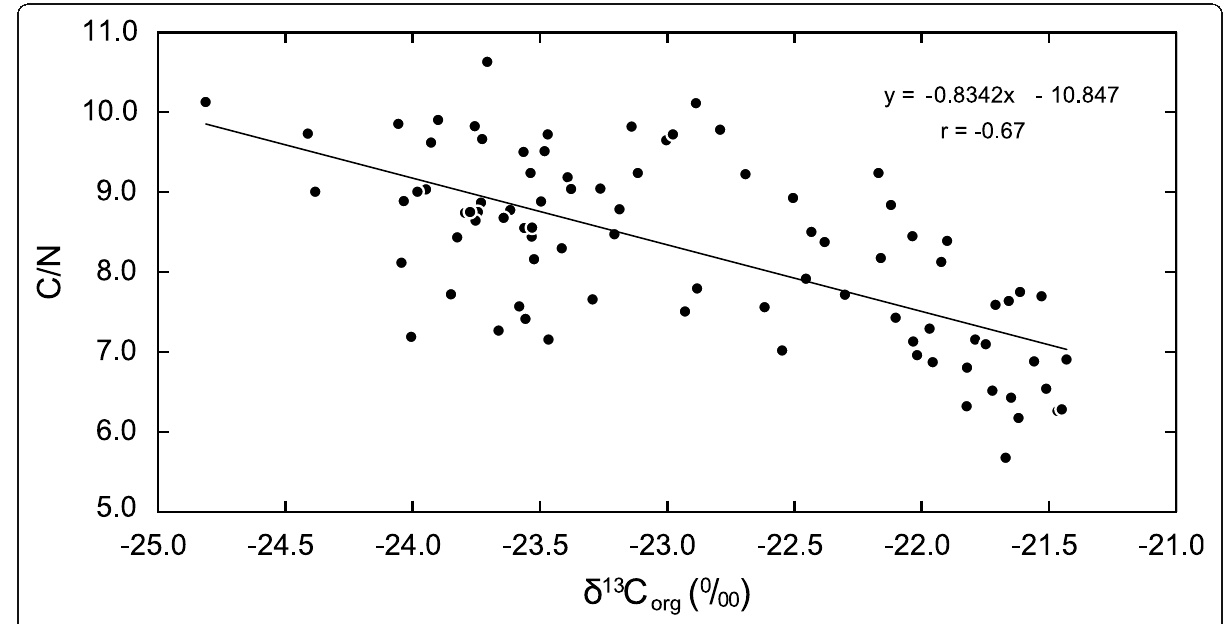
Fig. 8 Scatter plot of the δ 13 C org versus the C/N value. Note the moderate negative correlation ( r = −